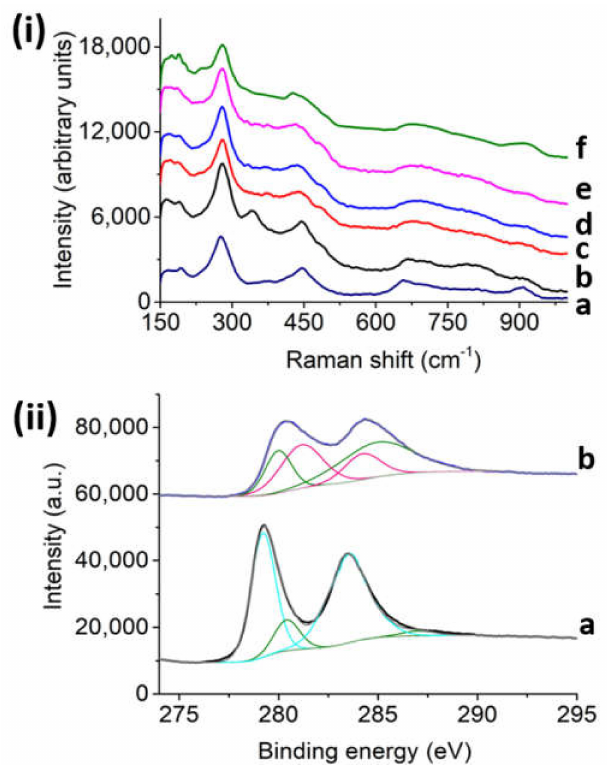
Figure 2. ( i ) Raman spectra recorded upon a 785 nm laser diode for the samples under study submitted to increasing temperatures from ambient to 240 ◦ C in a chamber under hydrogen atmosphere. (a) Room temperature Na,H / TiNT, (b) room temperature Ru / TiNT-11, (c) Ru / TiNT-11 at 150 ◦ C, (d) Ru / TiNT-11 at 180 ◦ C, (e) Ru / TiNT-11 at 210 ◦ C, and (f) Ru / TiNT-11 at 240 ◦ C; all spectra have been shifted in intensity axis for clarity. ( ii ) In situ XPS spectra of sample Ru / TiNT-11: (a) recorded at room temperature under vacuum. Blue lines correspond to raw XPS spectra, pink lines denote the presence of RuO 9 3d 5 / 2-9 / 2 species, and olive lines belong to the RuO 2 3d 5 / 2-9 / 2 species. (b) After submitting the sample for 1 h to a 5% H 2 stream under 210 ◦ C, in situ XPS was recorded at 210 ◦ C under vacuum. Black lines correspond to raw XPS spectra, olive lines belong to the RuO 2 3d 5 / 2-9 / 2 species, and cyan lines refer to metallic Ru,